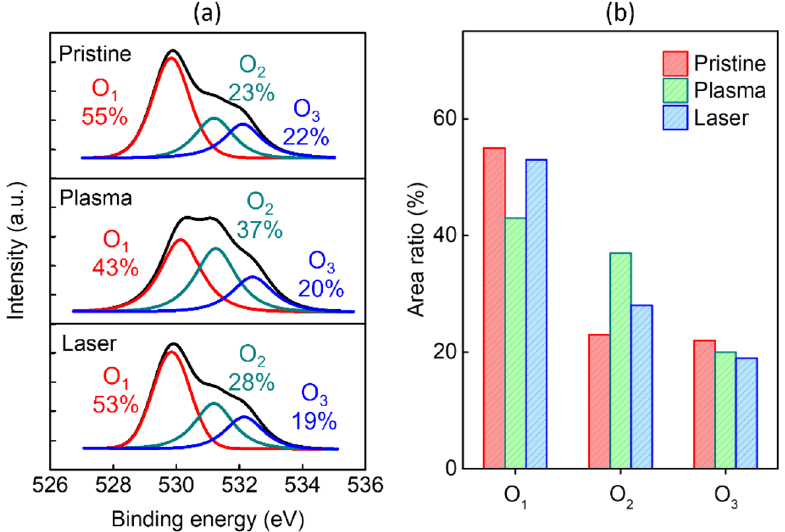
Figure 5. ( a ) XPS O 1s analysis of multi-stacked IZO films with pristine, plasma, and femtosecond laser pre- annealing. ( b ) Analytical areas of O1 peaks for M–O lattices, O V states, and O–H species based on different pre-annealing processes of pristine, plasma, femtosecond